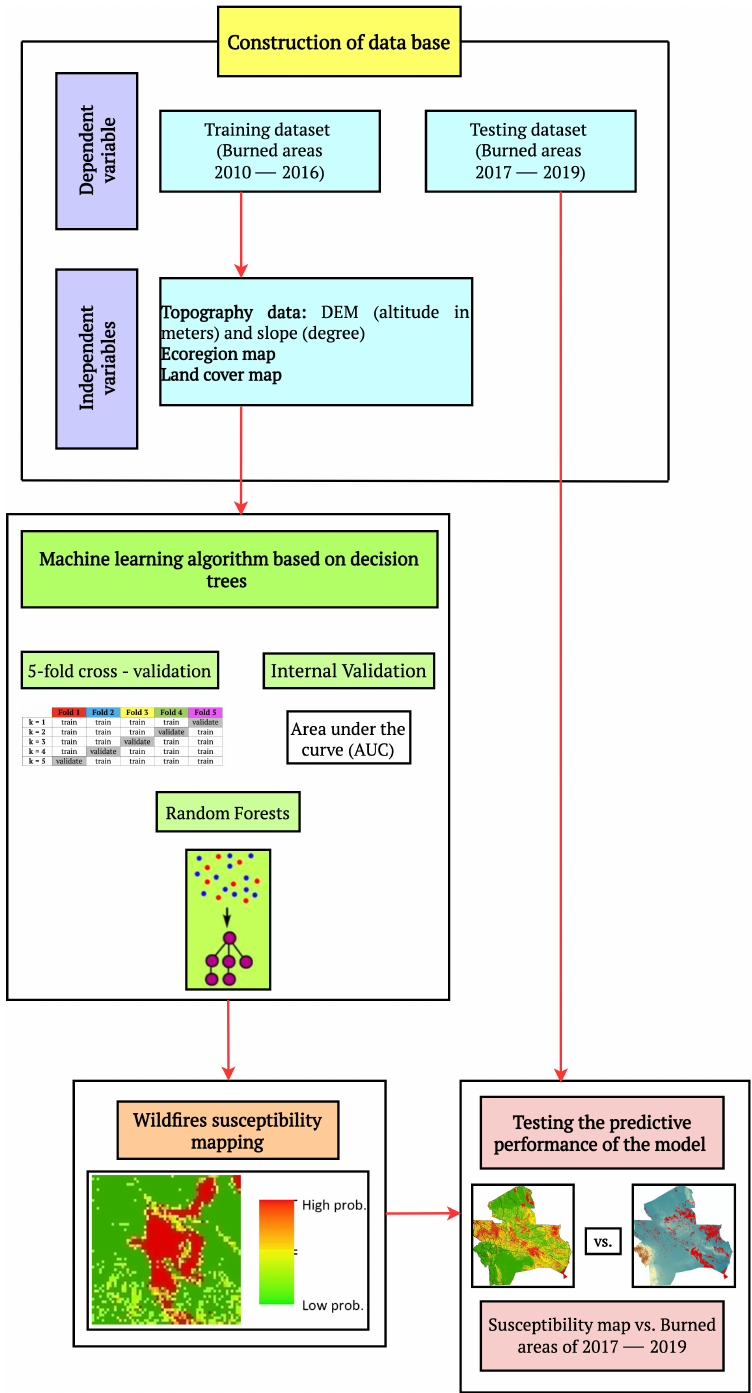
Figure 5. Workflow of the methodology employed in this